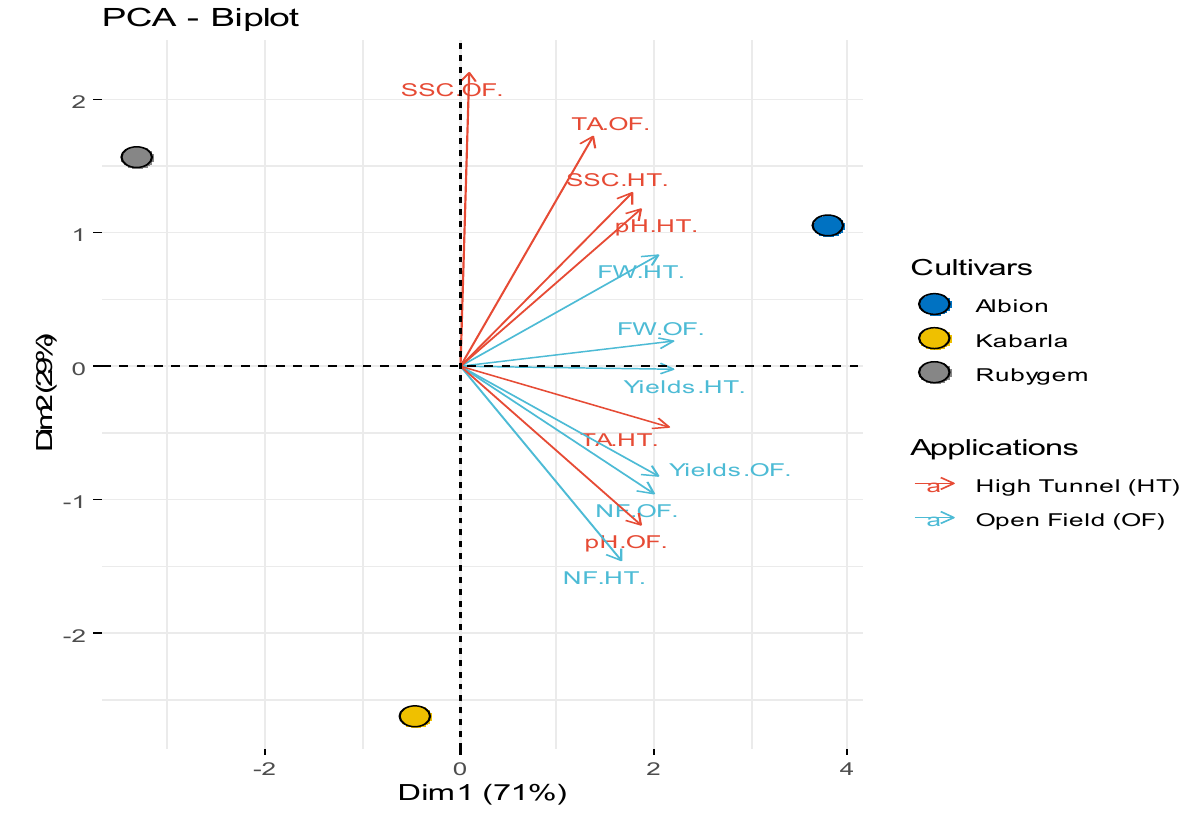
Figure 3. Principal component analysis (PCA) for fruit traits of different varieties and different ap-